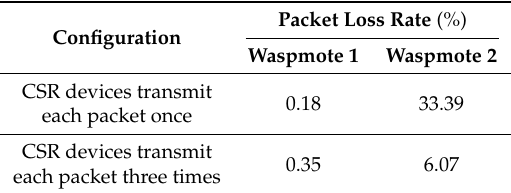
Table 5. PLR for 2 sensor devices using the CSR mesh topology, for different CSR device configurations.